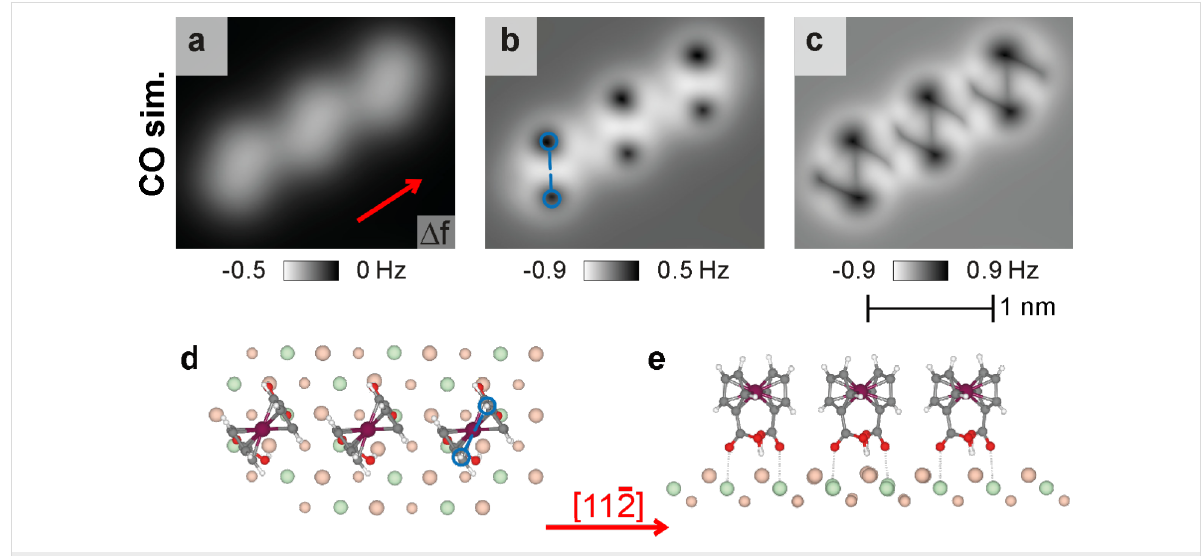
Figure 3: NC-AFM image calculation for a row of FDCA molecules in geo 2. (a–c) Constant-height frequency-shift Δ f data (inverted colour scale used) simulated at decreasing tip–sample distances for a row of FDCA molecules, each in geo 2. The red arrows mark the direction and the dashed blue line (forming an angle of 60° with the direction) the molecular orientation for geo 2. (d) Top view and (e) side view of the simulation cell using geo 2 from